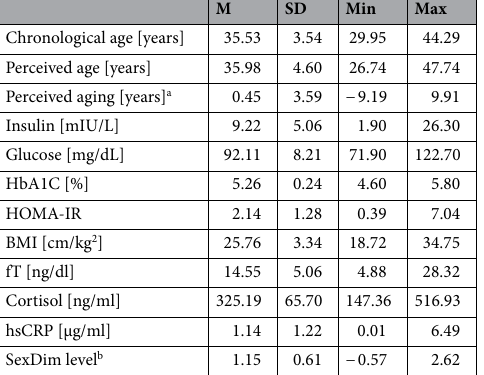
Table 1. Descriptive statistics of the studied variables in men (N = 116). a Difference between perceived and chronological age. b The level of sexual dimorphism.